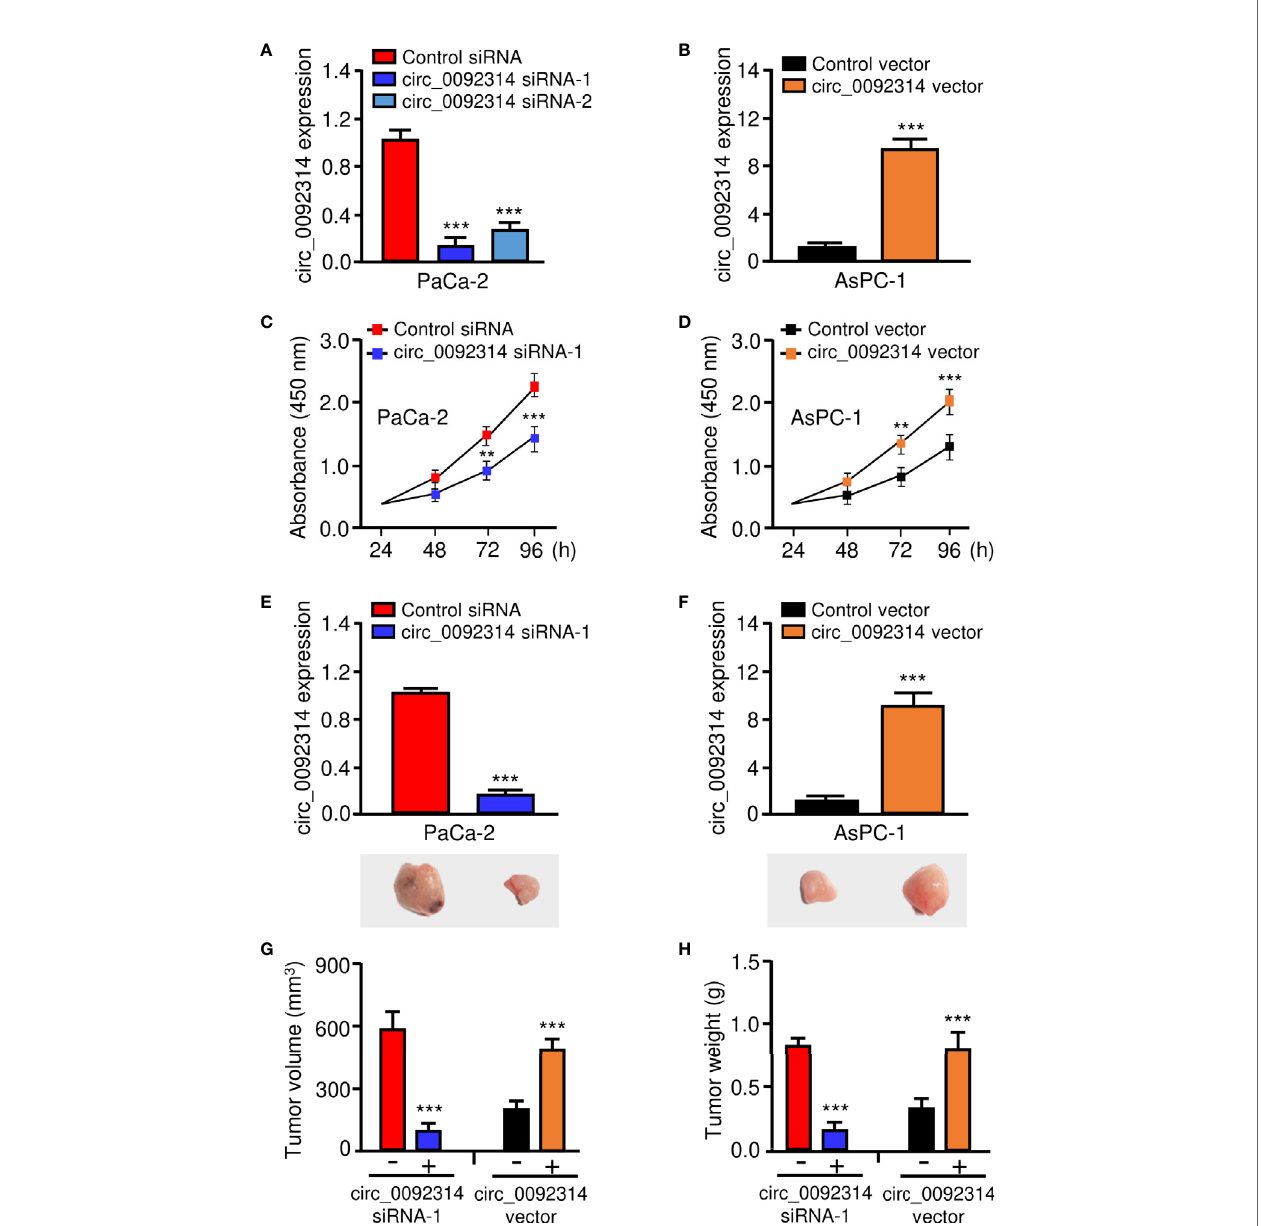
FIGURE 2 | Circ_0092314 enhances the proliferation of PAAD cells in vitro and in vivo . (A) The expression of circ_0092314 in PaCa-2 cells transfected with siRNAs targeting circ_0092314 or control siRNA. (B) The expression of circ_0092314 in AsPC-1 cells transfected with circ_0092314 overexpression vector or control vector. (C) CCK-8 assays in PaCa-2 cells transfected with siRNAs targeting circ_0092314 or control siRNA. (D) CCK-8 assays in AsPC-1 cells transfected with circ_0092314 overexpression vector or the control vector. (E, F) The expression of circ_0092314 in PaCa-2 (E) and AsPC-1 (F) cells was examined using qRT-PCR assay. The lower panels showed the representative images of xenograft tumors in nude mice. (G, H) Tumor volume (G) and tumor weight (H) were measured from each group after 21 days. ** P <0.01, *** P